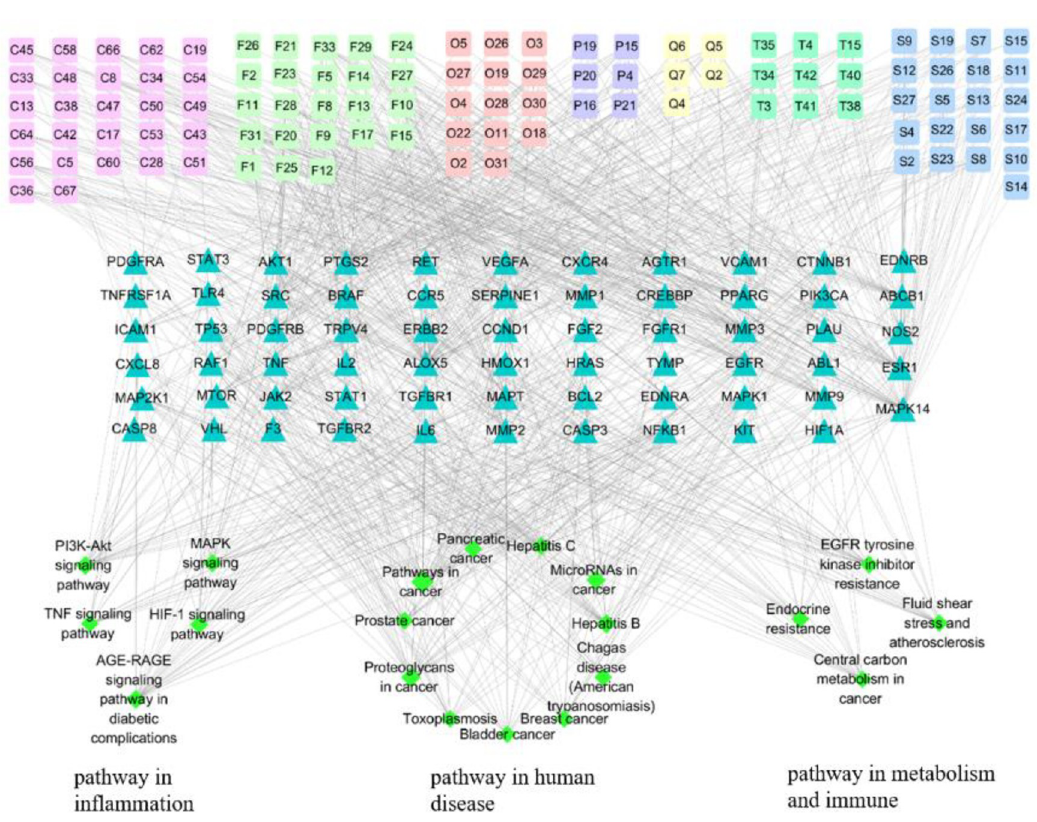
Fig 5. Component-target-pathway network comprised 190 nodes and 1042 edges. The rectangle nodes represent 105 components identified in AJH, the triangle nodes represent 65 COPD-related targets, and the diamond nodes represent the top 20 enriched pathways. The edges represent interactions between compounds, targets and